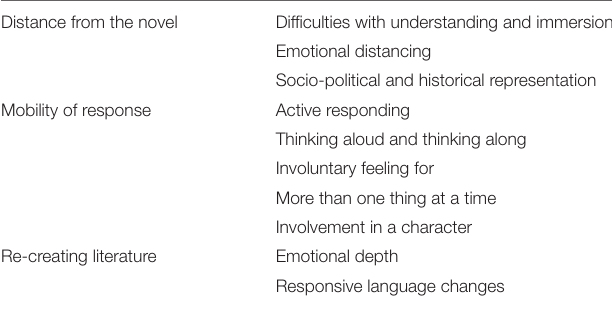
TABLE 3 | Final analysis themes and